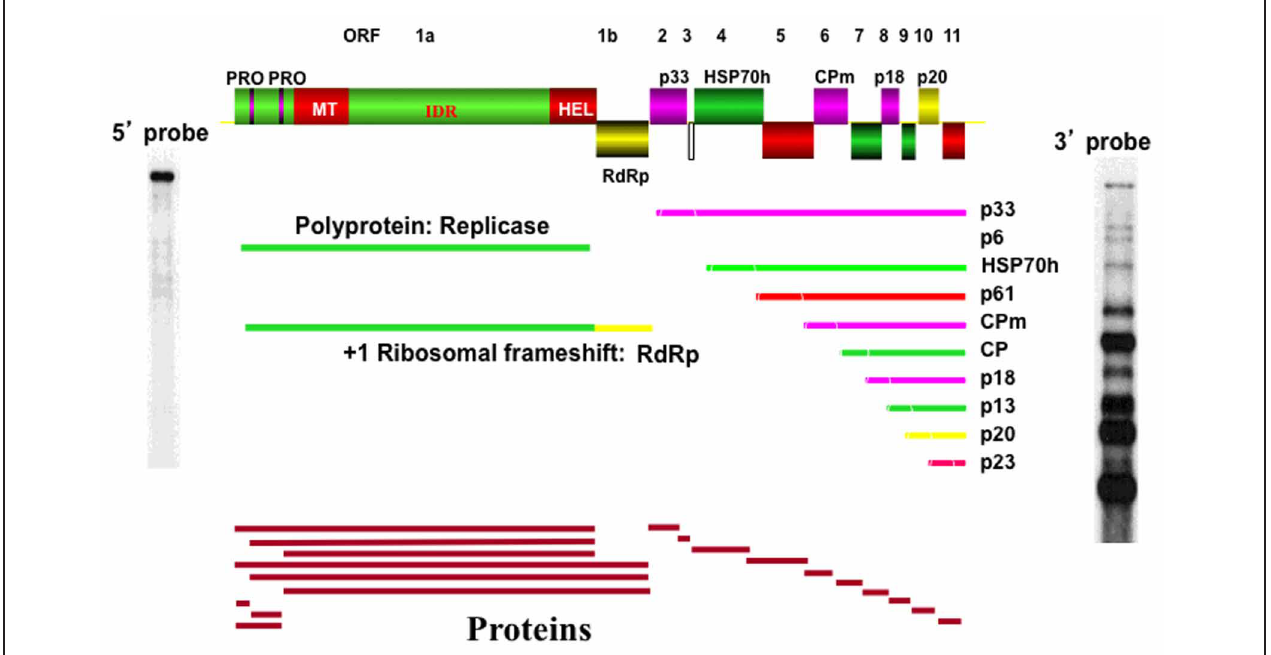
FIGURE 1 | A schematic diagram of the genetic organization of CTV showing ORFs (open boxes) of each gene. PRO, papain-like proteases; MT, methyl transferase-like domain; IDR, large interdomain region; HEL, helicase-like domain; RdRp, RNA-dependent RNA polymerase domain; HSP70h, analog to heat shock protein; CPm and